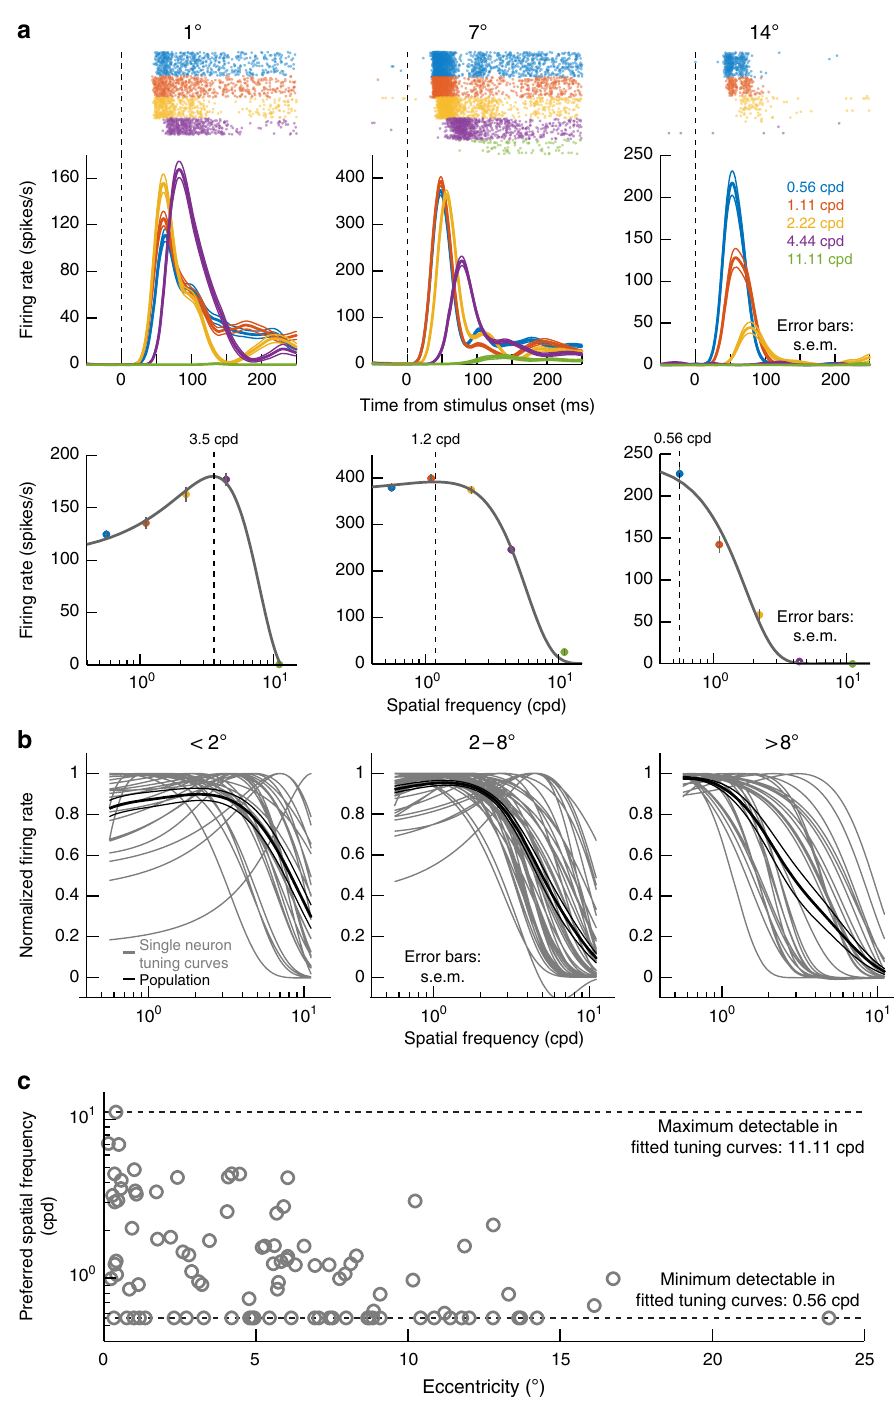
Minimum detectable in fitted tuning curves: 0.56